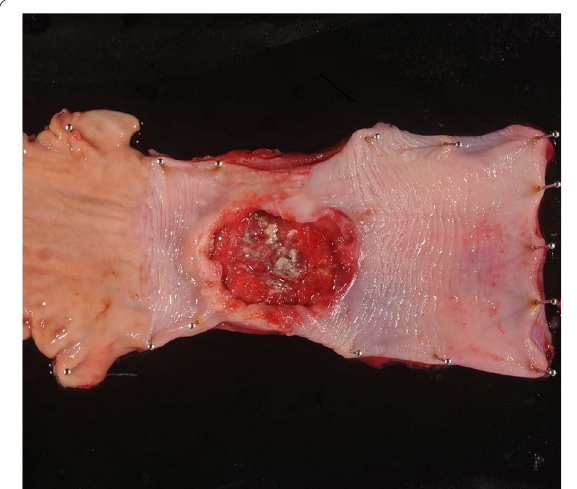
Fig. 2 Findings of the resected specimen in Case